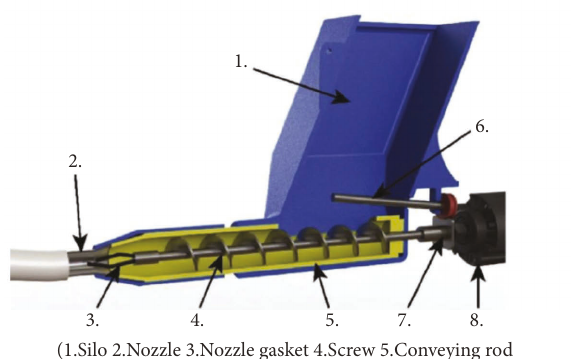
Figure 7: Examples of common extrusion systems